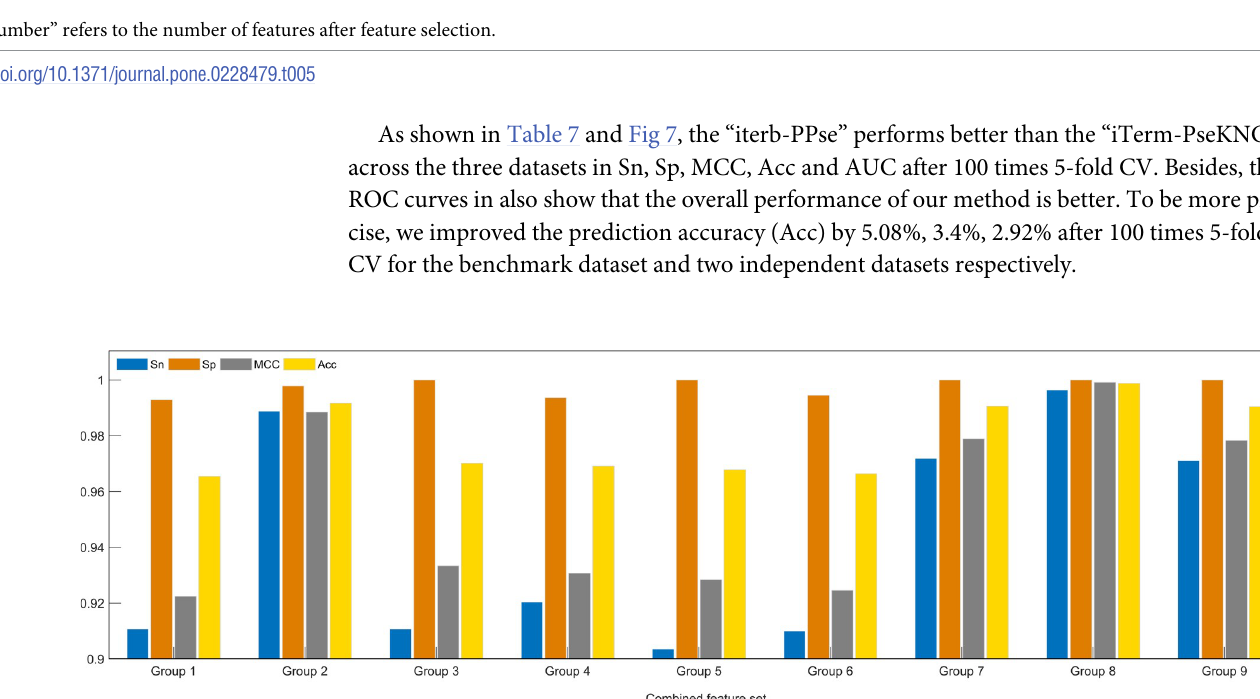
Fig 6. Classification results using different combined features. These results are obtained using XGBoost after 100 times 5-fold